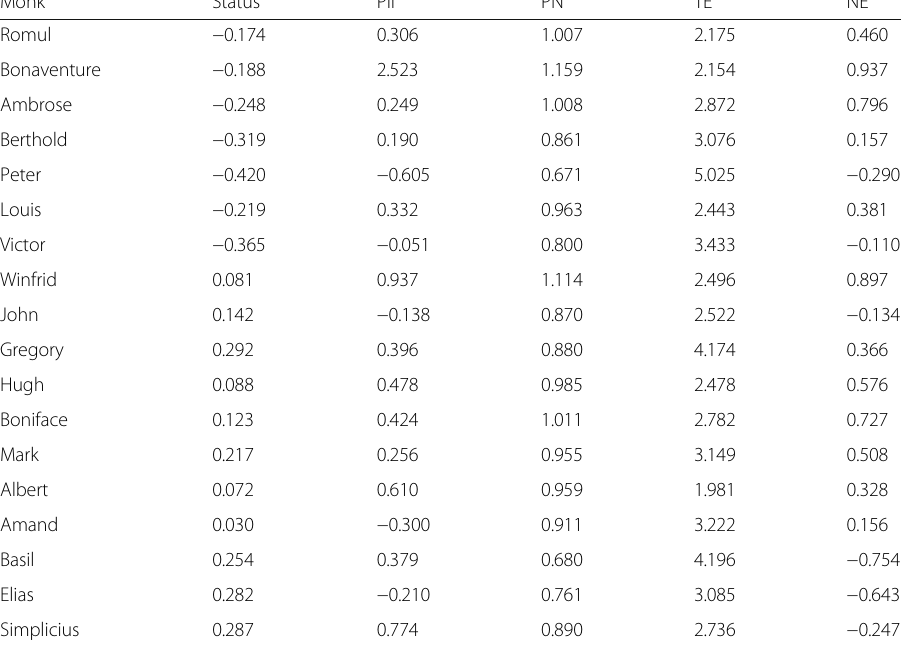
Table 5 Different centrality values calculated on the like-dislike relation network from Sampson ’ s Monastery social network dataset. TE and NE stand for total effect and net effect as derived from our new methodology, all other values were calculated using UCINET (Borgatti et al. 2002) Monk Status PII PN TE NE −